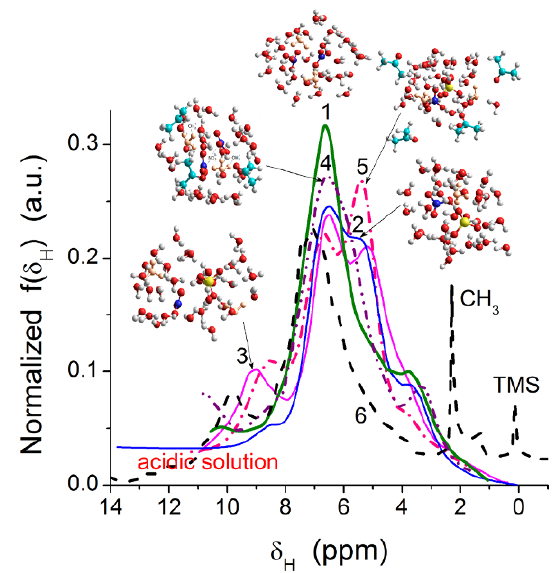
Figure 8. Calculated 1 H NMR spectra (PM7 with the calibration function) of (1) dimer of nitric acid with dissolution of NO-H bonds and transfer of two protons toward water molecules; dimer of nitric and sulfuric acids with dissolution of (2) NO-H and (3) NO-H and one SO-H; (4) complex (1) with addition three acetone molecules; (5) complex (3) with addition of four acetone molecules; (6) experimental 1 H NMR spectrum (Fig. 4a, T = 280 greater the content of dissolved acids, the higher the γ S’ value is. However, the enhancement of the nanoporosity of NC causes an increase in the −∆ G and C uws values s (Table 1) characterizing the strongly bound water. This is due to the enhancement of the confined space effects in nanopores as it is described by the Gibbs-Thomson Eq. 2.